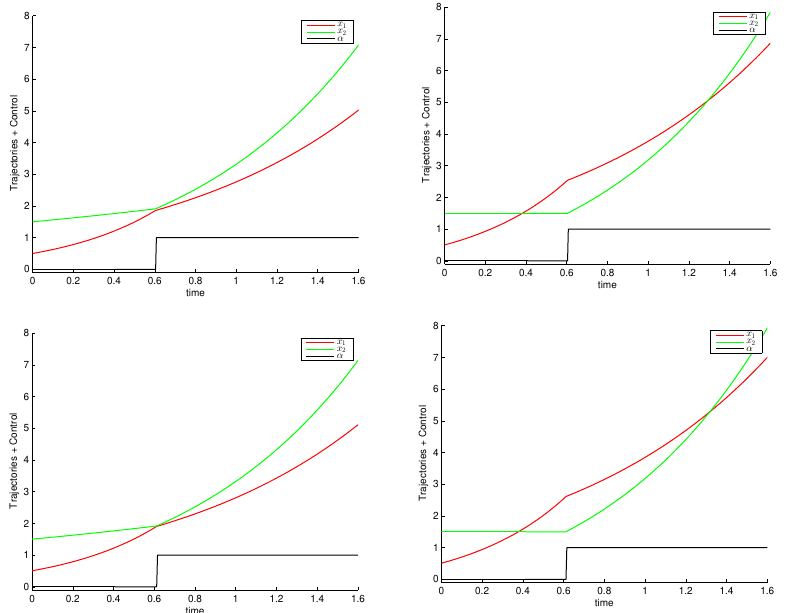
Figure 2. Exact optimal control (top) and optimal control computed with Bocop ( bottom ) for r 2 = 0.1 ( left ) and r 2 = 0.5 ( right